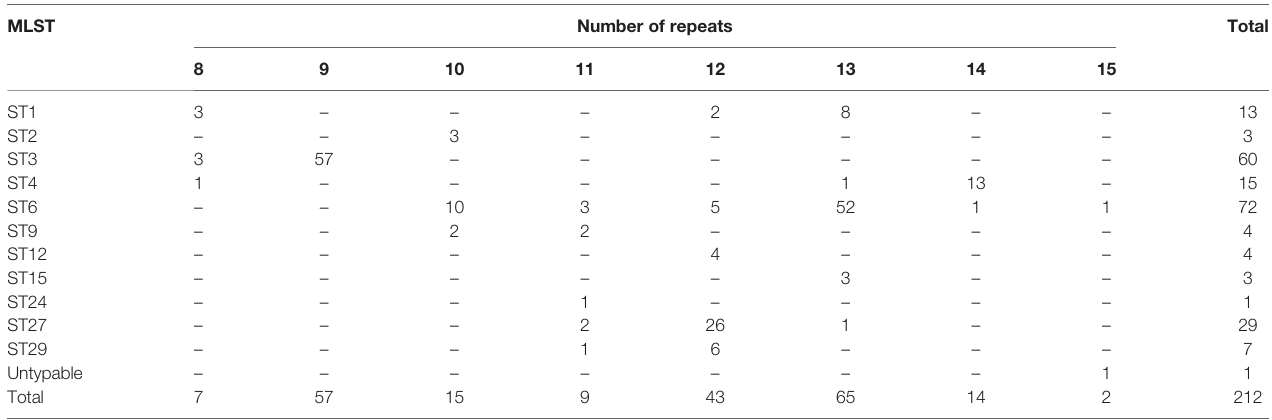
TABLE 2 | Number of repeats in the R region of vWbl in the various MLST types. MLST